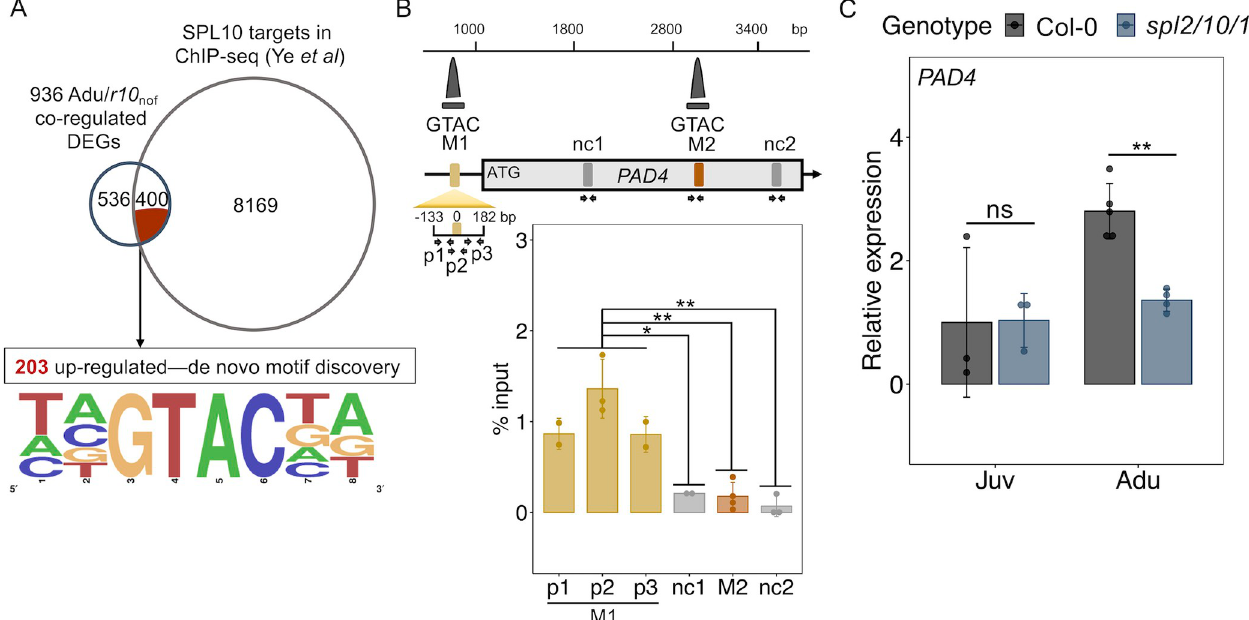
Fig 6. PAD4 was a direct target of SPL10. A , overlap between Adu/ r10 co-regulated genes and potential SPL10 targets defined according to ChIP-seq data nof from Ye et al . (upper panel) [24]. A motif discovery and enrichment analysis of the 203 Adu/ r10 nof co-upregulated DEGs (lower panel). B , SPL10 bound to a GTAC-containing motif upstream of PAD4 . qPCR following chromatin immunoprecipitation of rSPL10 -YFP for motifs (M1 and M2) and negative control sites (nc1 and nc2), the latter of which are at least 600 bp away from M1 and M2 at the PAD4 genomic region. Three primer sets (p1-p3) were used to amplify the M1 site. Relative locations of ChIP peaks (dark grey) derived from Ye et al , primers (arrow pairs) and the tested sites (color blocks) were indicated in the schematic diagram. The student t test was performed to compare and indicate the significance of difference between the sites. C , qPCR of PAD4 transcripts level in juvenile (Juv) and adult (Adu) leaves of Col-0 and spl2/10/11 . The student t test, ns, not significant, � , p < 0.05, �� , p < 0.01.